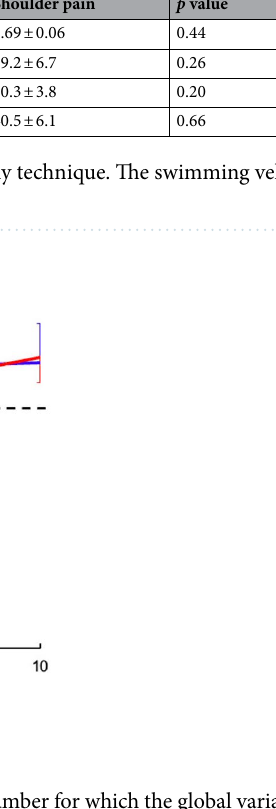
Figure 3. The number of synergies was set as the lowest number for which the global variance accounted for (VAF) exceeded 90%. When the number of synergies was 4, the VAF exceeded 90% in both the control and the swimmer’s shoulder